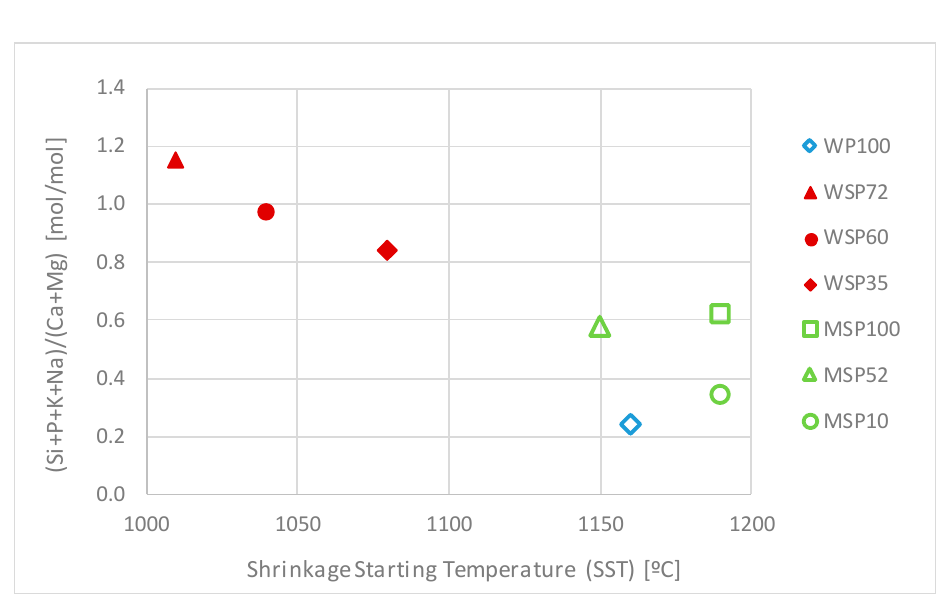
Figure 1. Ratio (Si + P + K + Na)/(Ca + Mg) versus SST.